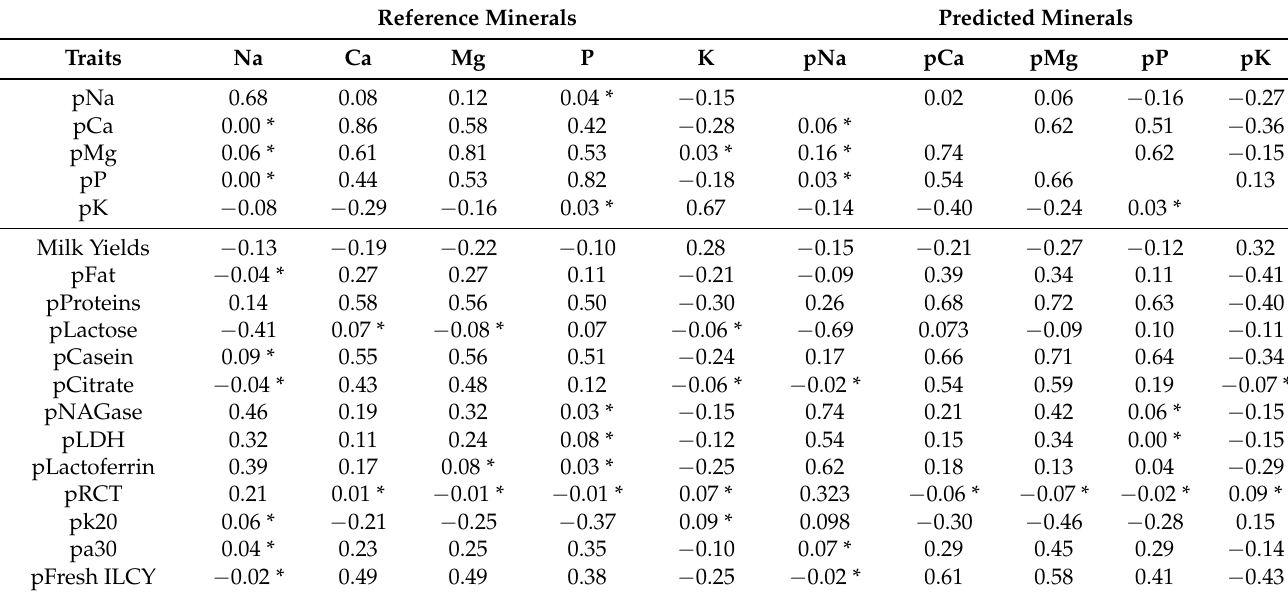
Table 4. Observed correlations between measured and predicted mineral levels, milk yields 1 (L), and predicted traits as pFat 2 (g/100 g), pProteins 2 (g/100 g), pCasein (g/100 g), pCitrate (mmol/L), pLactose 2 (g/100 g), pNAGase